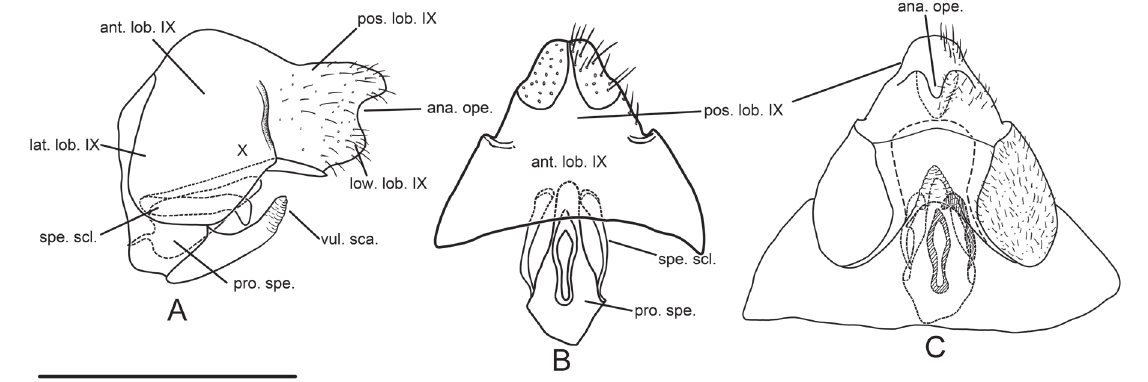
Fig. 5. Female genitalia of Apatidelia morsei Xu & Sun sp. nov. A . Lateral view. B . Dorsal view. C . Ventral view. Scale bar = 0.5